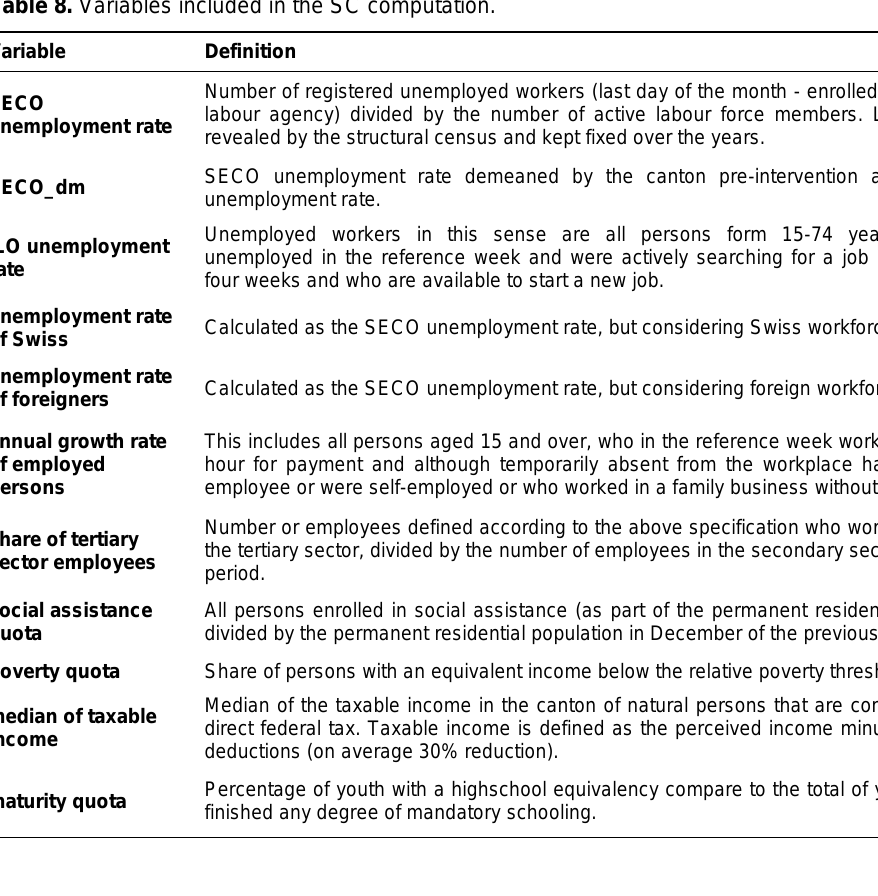
Table 8. Variables included in the SC